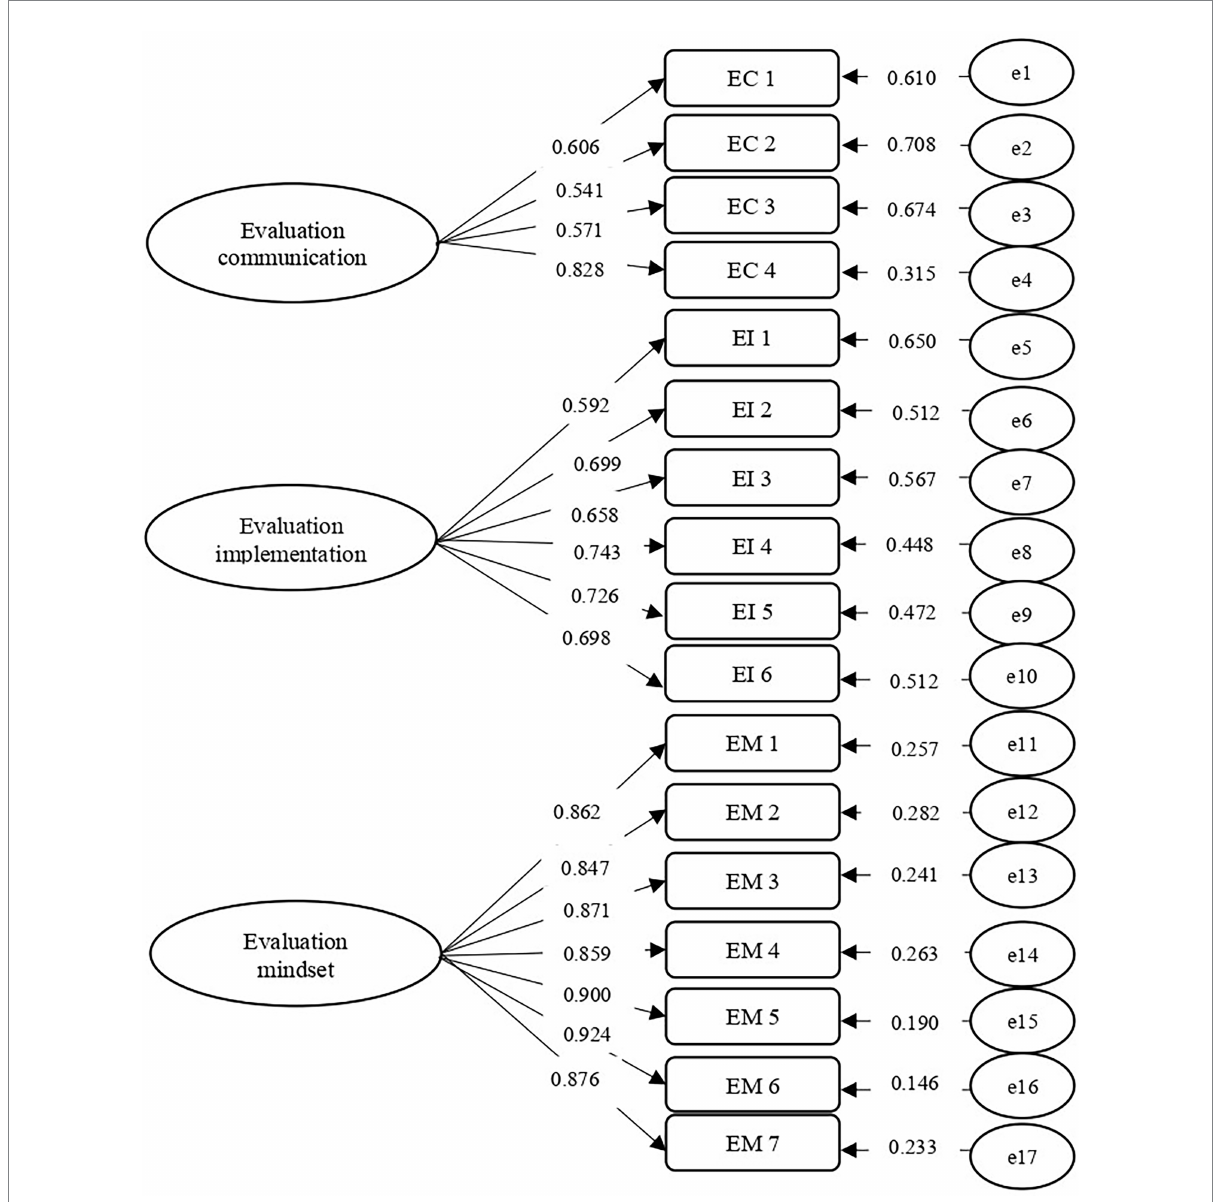
FIGURE 1 Validation of the Factor Structure with CFA ( n = 202). All coefficients displayed in this figure were factor loadings that are statistically significant at p < 0.001 level. EC = Evaluation communication; EI = Evaluation implementation; EM = Evaluation